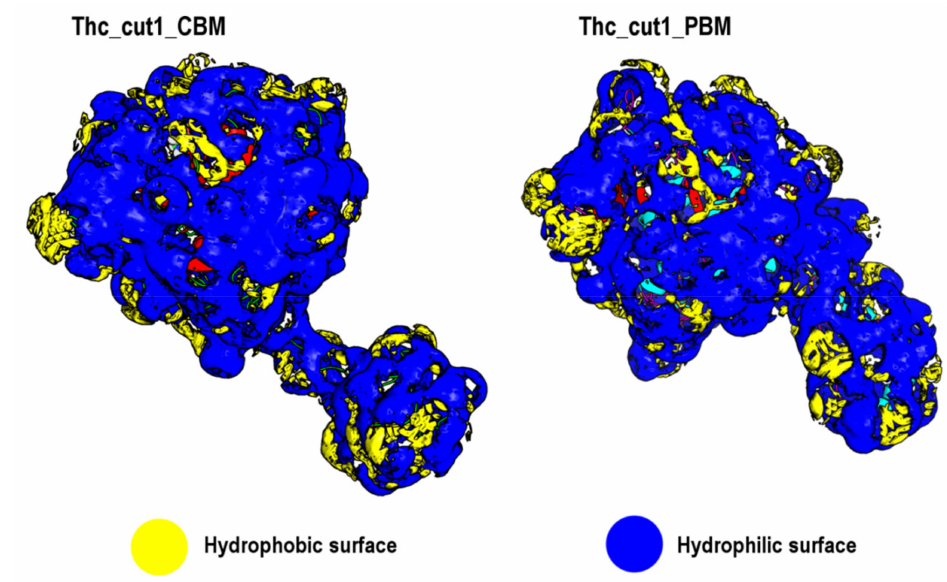
Figure 5. Surface analysis of Thc_Cut1_CBM and Thc_Cut1_PBM after MD equilibration. Hydropho- bic surfaces are highlighted in yellow, hydrophilic surfaces are indicated in